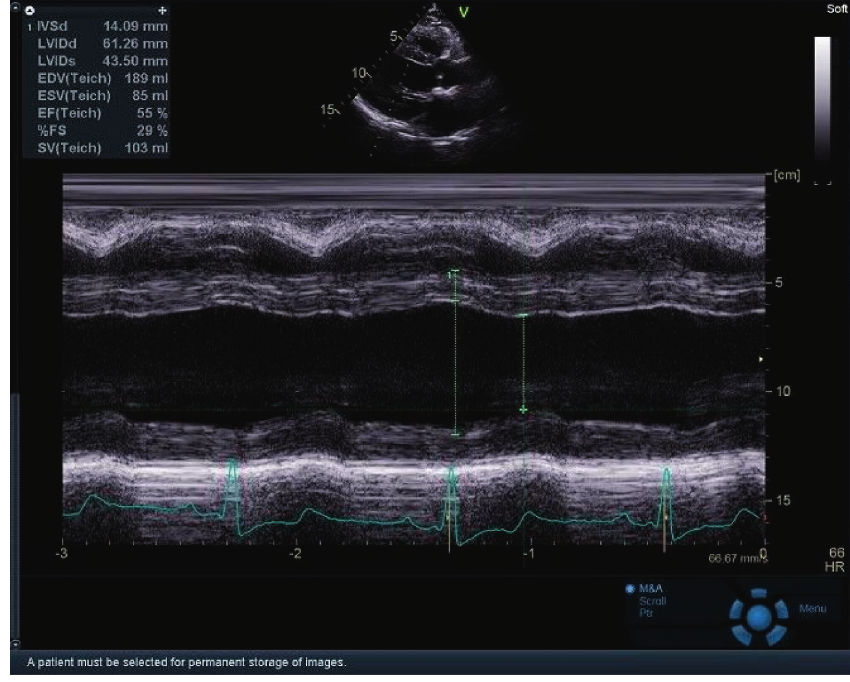
Figure 1: Echocardiographic analysis of left ventricular mass. Table 1: Baseline characteristics of the study population.